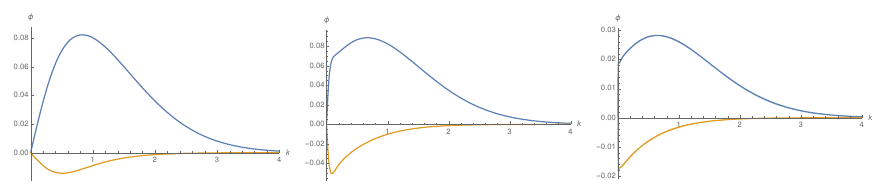
Figure 8. The J PC = 1 ++ , 3 P 1 normalized axial vector (A) radial wave functions φ + (in blue) and φ − (in yellow), from left to right for the ground state vacuum and first two replicas, in dimensionless in units of K 0 = 1.